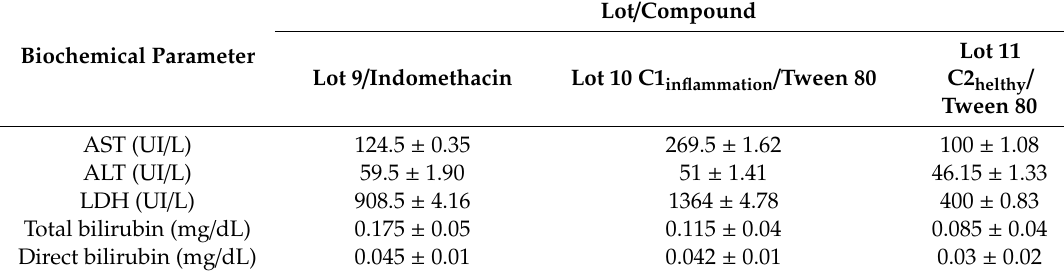
Table 7. Parameter values of liver function in rats from groups Indomethacin, C1 inflammation , Tween 80 and C2 healthy , Tween